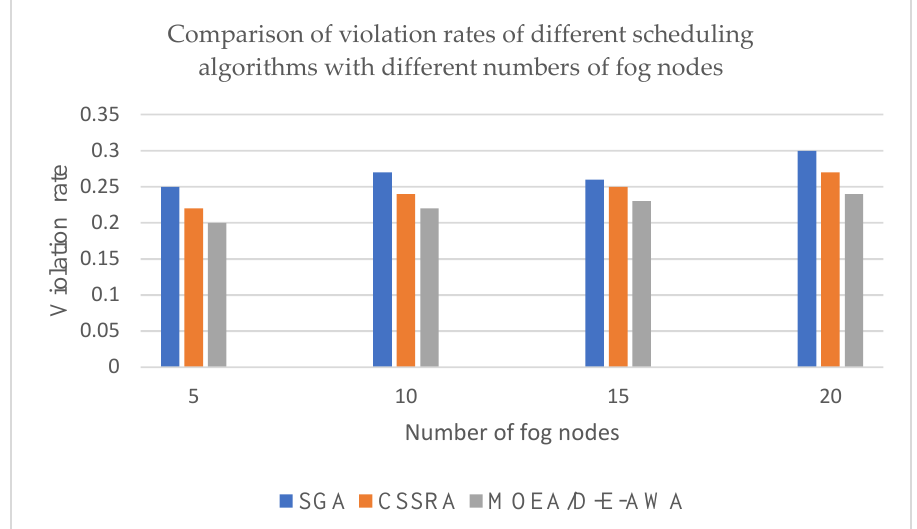
Figure 7. Comparison of Violation Rate.